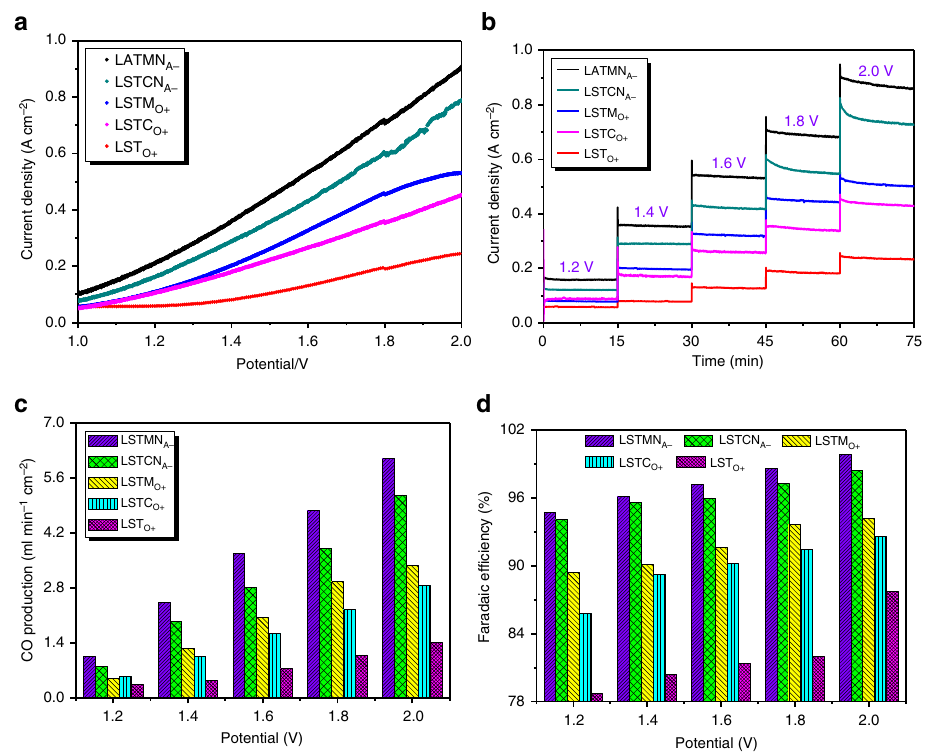
Figure 5 | Electrolysis performance. ( a ) I–V curves of CO 2 electrolysis with different cathodes at 800 (cid:2) C; ( b ) short-term performances of CO 2 electrolysis at different voltages; ( c ) CO production and ( d ) current efficiency with different